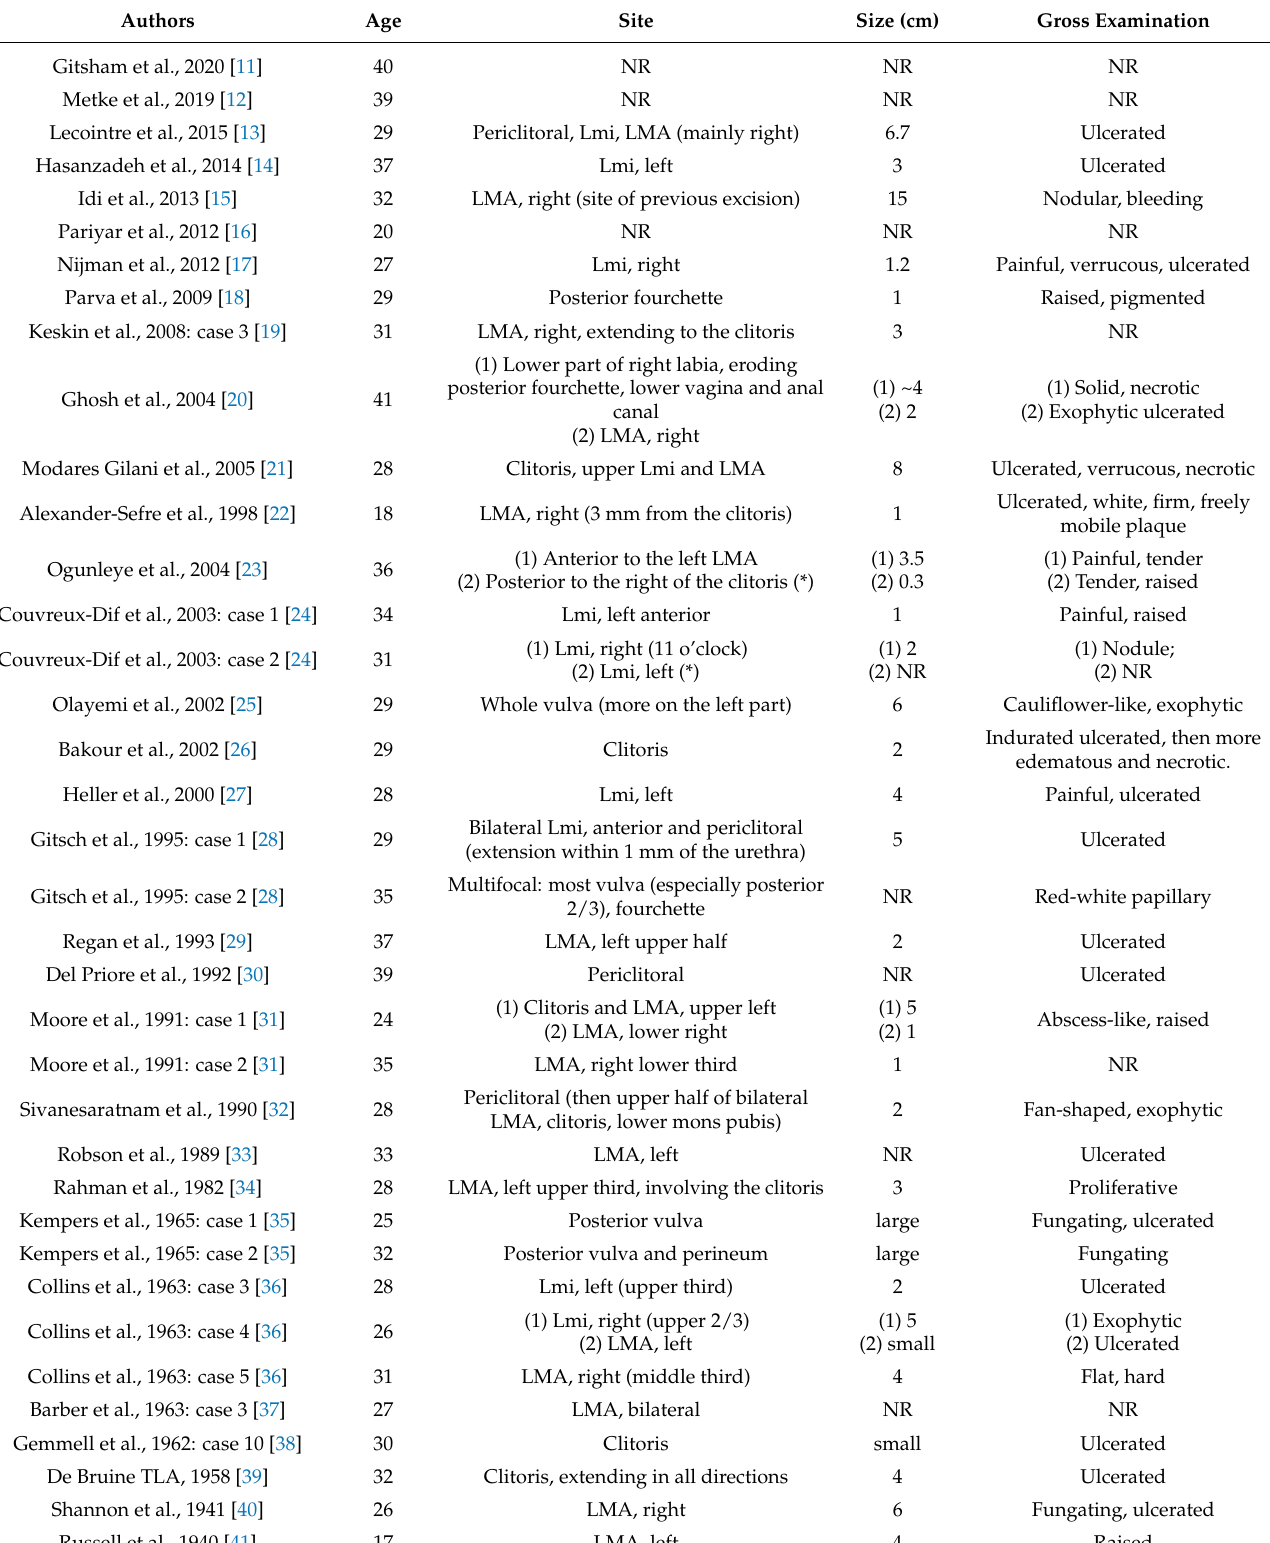
Table 1. Primary vulvar squamous cell carcinomas: macroscopic